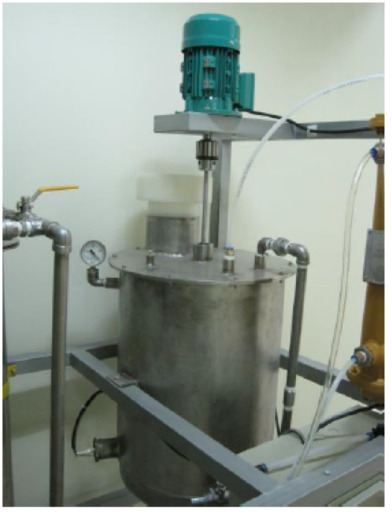
Figure 5. The fabricated 70 L reactor for biodiesel production [55].